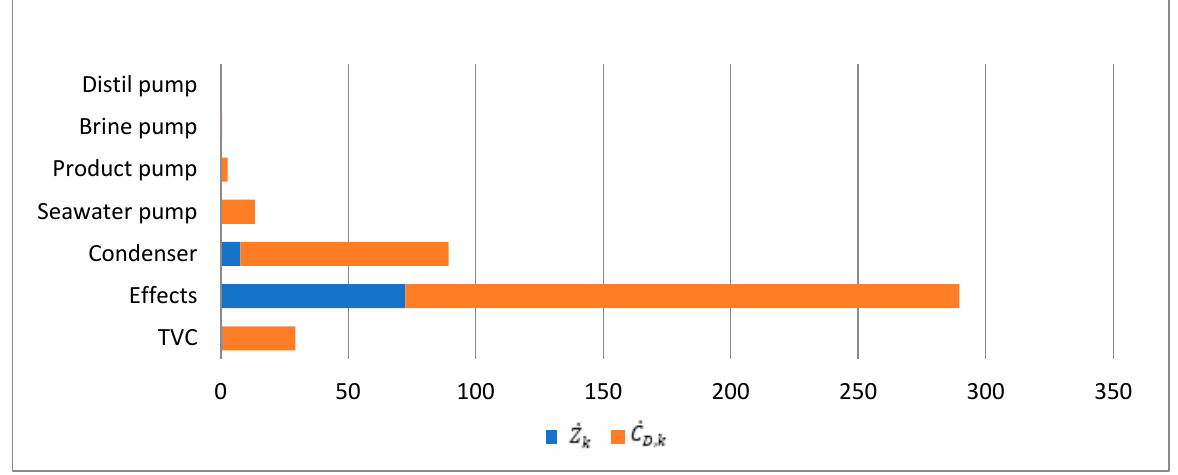
Figure 3. The sum of ( 𝑍(cid:4662) (cid:3038) + 𝐶(cid:4662) (cid:3005),(cid:3038) ) for the MED-TVC system components. It can be seen from Figure 3 that the highest sum ( 𝑍(cid:4662) (cid:3038) + 𝐶(cid:4662) (cid:3005),(cid:3038) ) is for the effects, fol- lowed by the condenser. The exergoeconomic factor of the effects is 24.9%, suggesting that the capital cost has a relatively much lower rate than the cost of exergy destruction. Therefore, 75.1% of the total cost associated with the effects is due to its high thermodynamic ineffi- ciency (high exergy destruction). The second cost ineffective component in the system is the condenser; its exergoeconomic factor is observed to be 8.6%, meaning that only 8.6% of the cost is owing to component capital cost and 91.4% of the cost is because of high exergy destruction. The third cost ineffective component in the system is found to be the TVC unit, and its exergoeconomic factor is obtained to be approximately 2.4%, which means that only 2.4% of the cost is owing to component capital cost and 97.6% of the cost is owing to high exergy destruction.